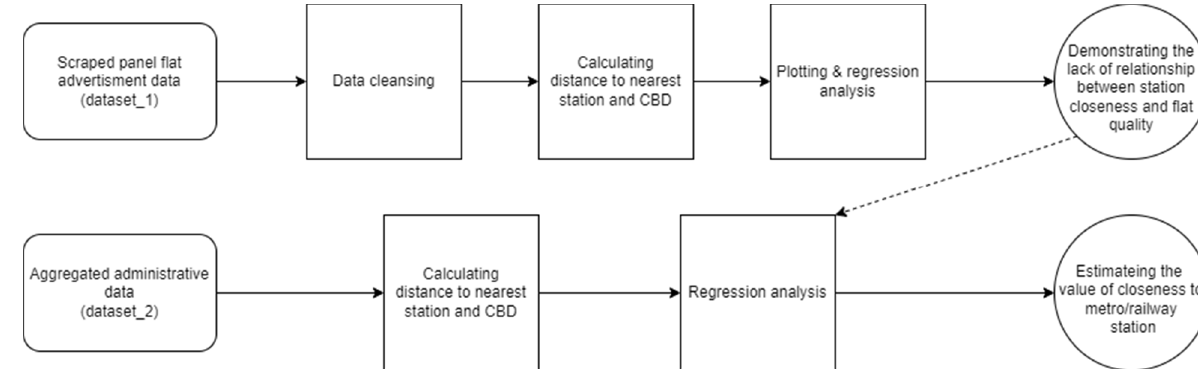
Figure 1. Workflow of the paper.